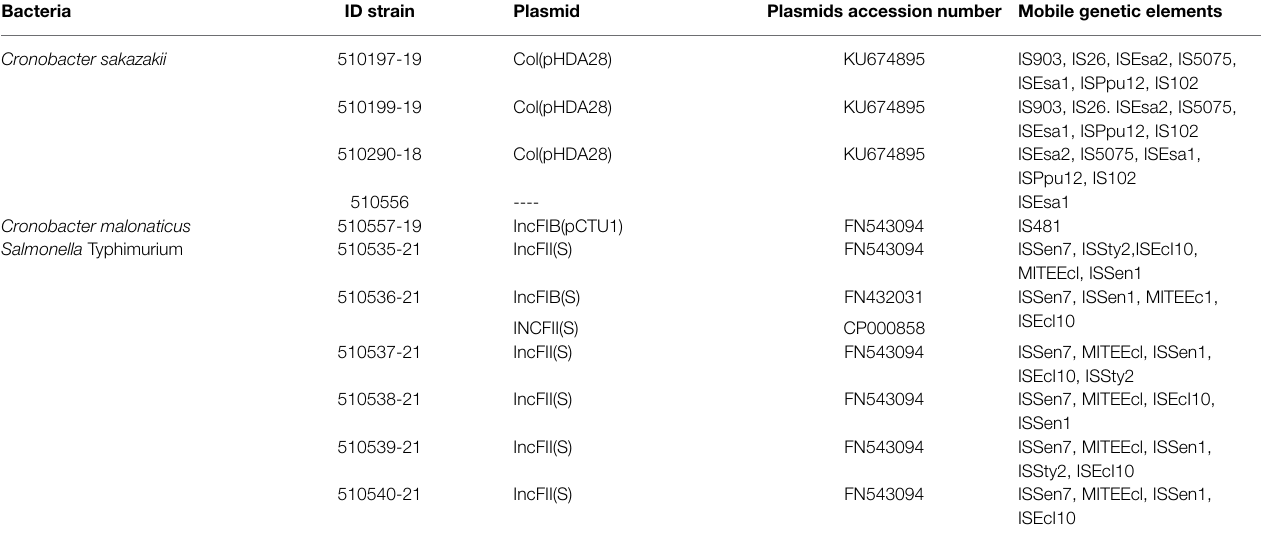
TABLE 7 | Plasmids and mobile genetic elements of Cronobacter spp. and S. Typhimurium. Bacteria ID strain Plasmid Plasmids accession number Mobile genetic elements Cronobacter